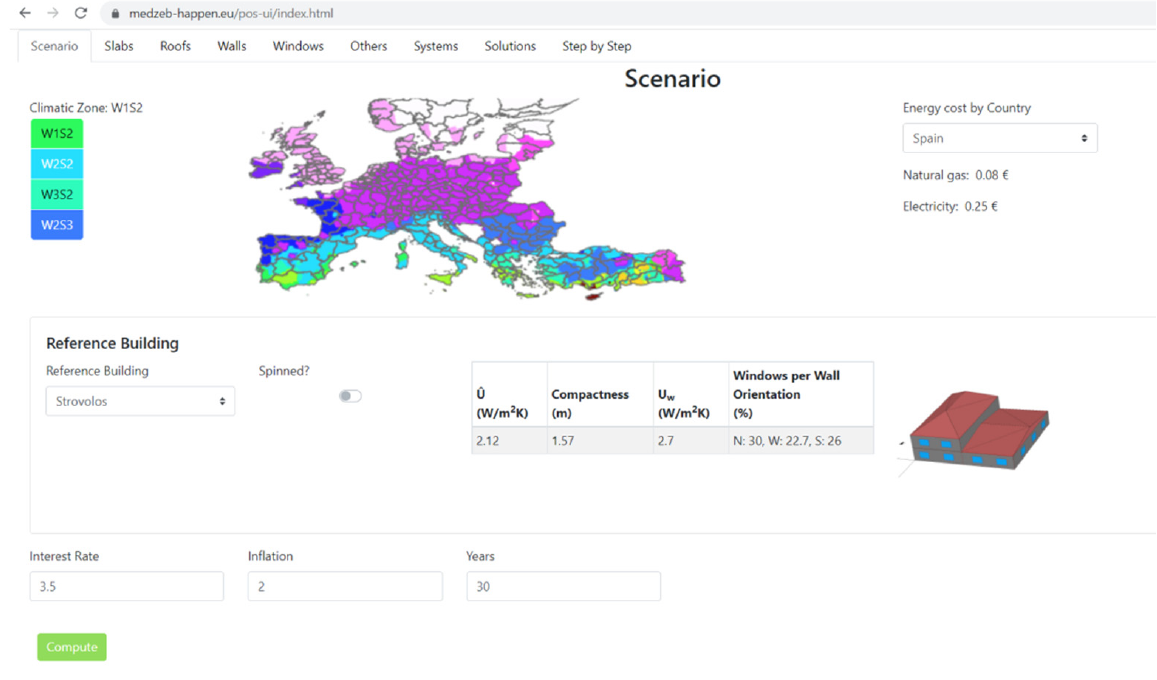
Figure 5. POS1 Scenario.